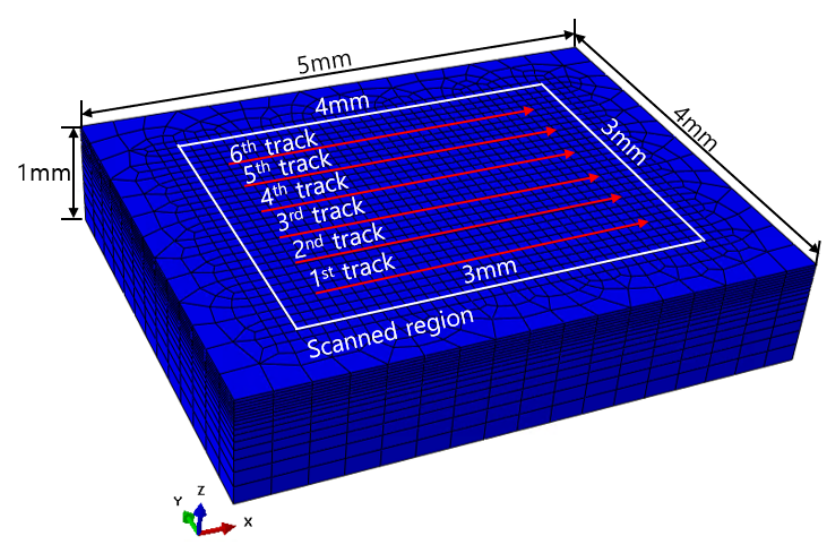
Figure 1. Finite element analysis model and scan strategy.